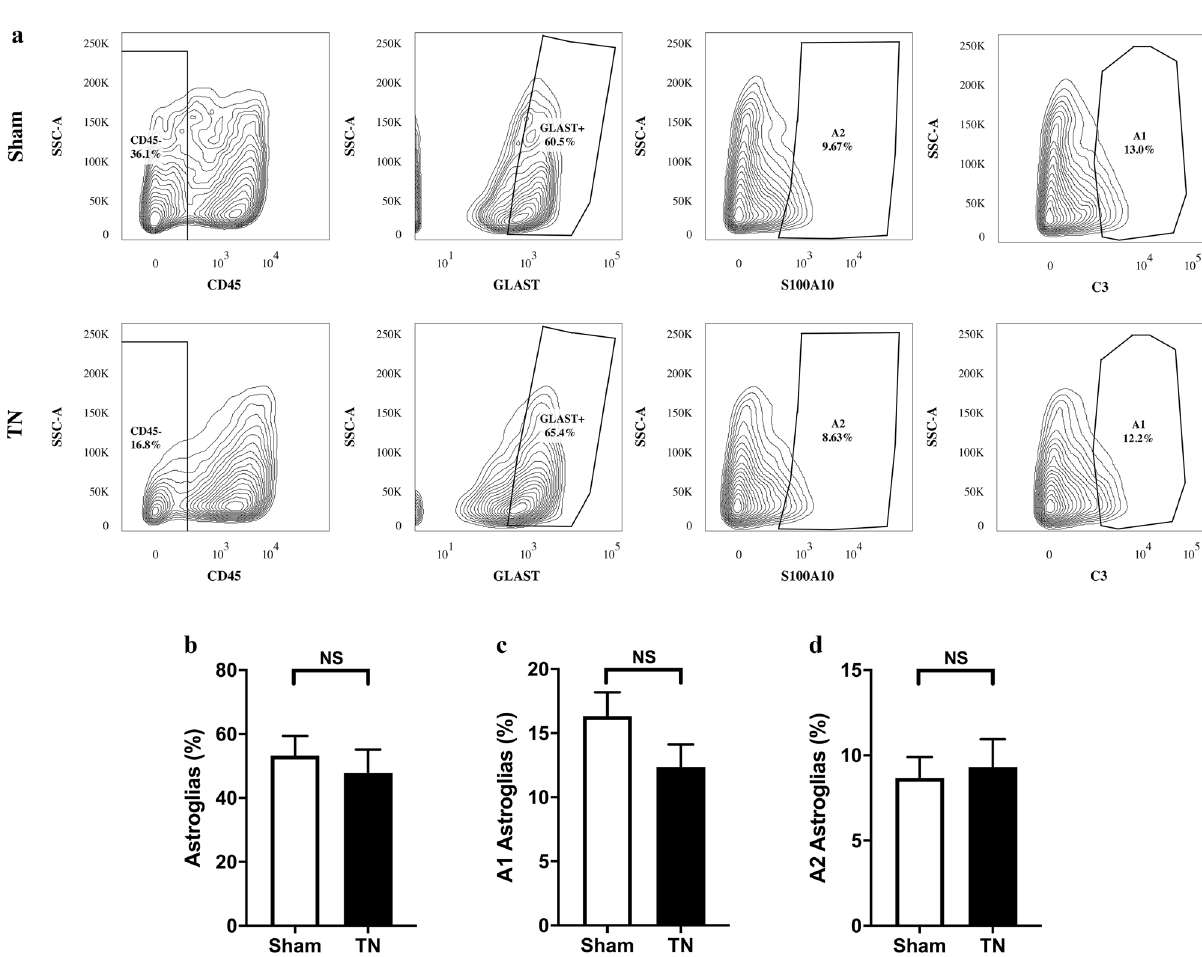
Figure 5. The proportions of different types of astrocytes in the TREZ and TG. ( a ) Flow contour plot of mature astrocytes (CD45 − GLAST + ), A1 astrocytes (CD45 − GLAST + C3 + ) and A2 astrocytes (CD45 − GLAST + S100A10 + ) in the TREZ and TG in the two groups of rats. ( b – d ) The difference between mature astrocytes (CD45 − GLAST + ) and A2 astrocytes (CD45 − GLAST + S100A10 + ) in the TN group and sham group was not statistically significant. Compared with the sham group, the proportion of A1 astrocytes (CD45 − GLAST + C3 + ) in the TN group showed a downward trend ( p = 0.1599). ns: not significant, as determined by two-tailed Student’s